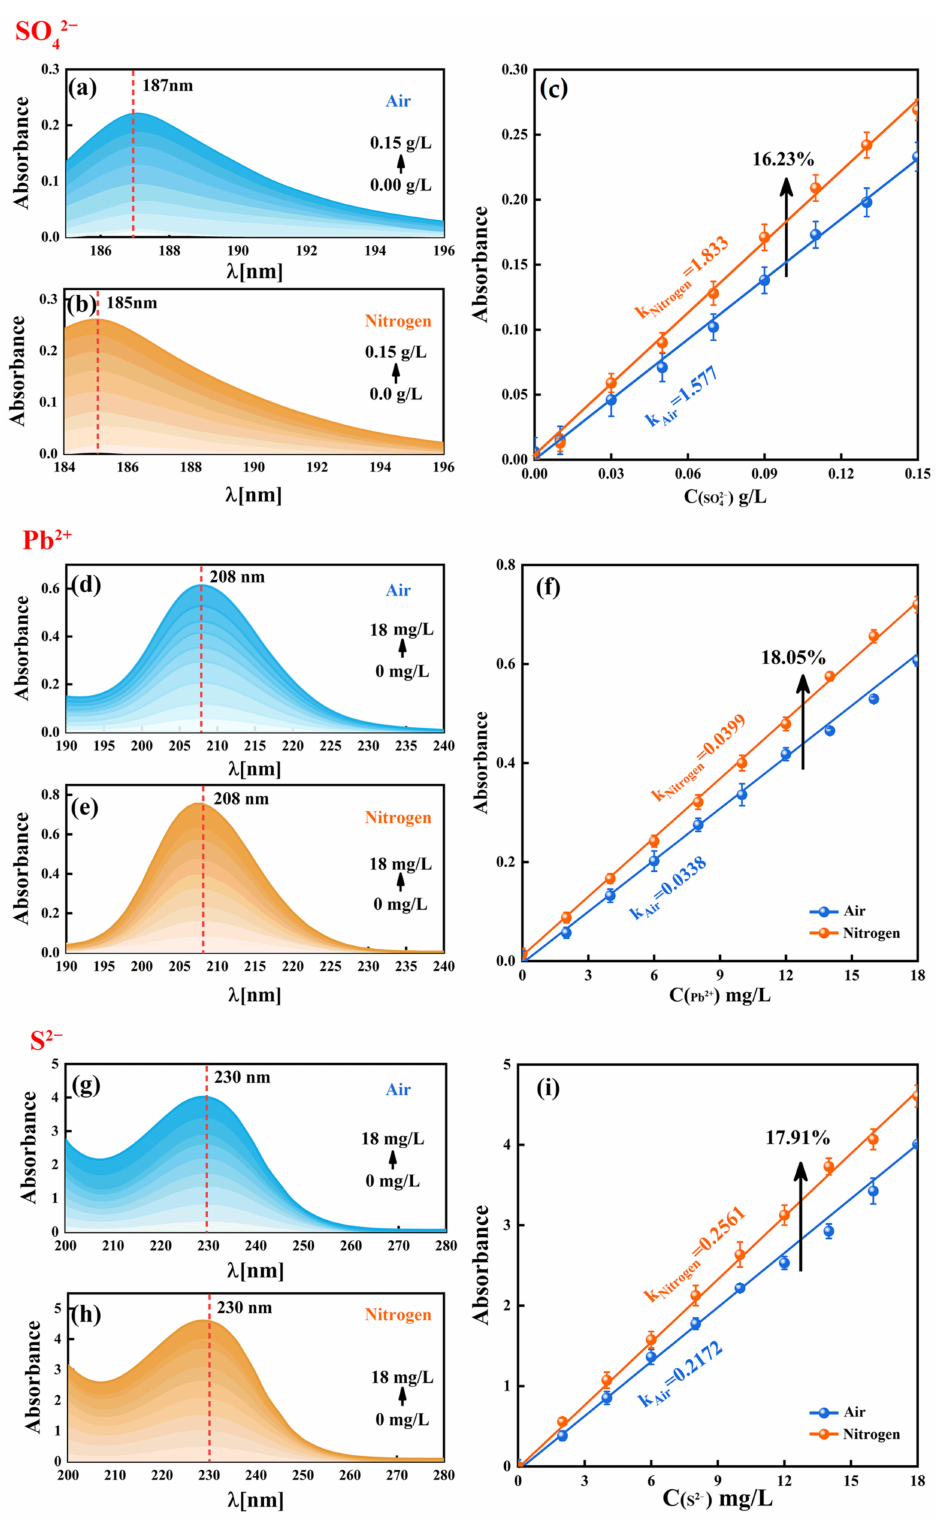
Figure 5. Spectral curves and C − A fitting curves of SO 4 2 − , Pb 2+ and S 2 − in air and nitrogen atmosphere at b = 10 mm, where ( a , b ) are spectral curves of SO 4 2 − in air and nitrogen atmosphere, ( c ) C − A fitting curves of SO 4 2 − , ( d , e ) are spectral curves of Pb 2+ in air and nitrogen atmosphere, ( f ) C − A fitting curves of Pb 2+ , ( g , h ) are spectral curves of S 2 − in air and nitrogen atmosphere, ( i ) C − A fitting curves of S 2 −